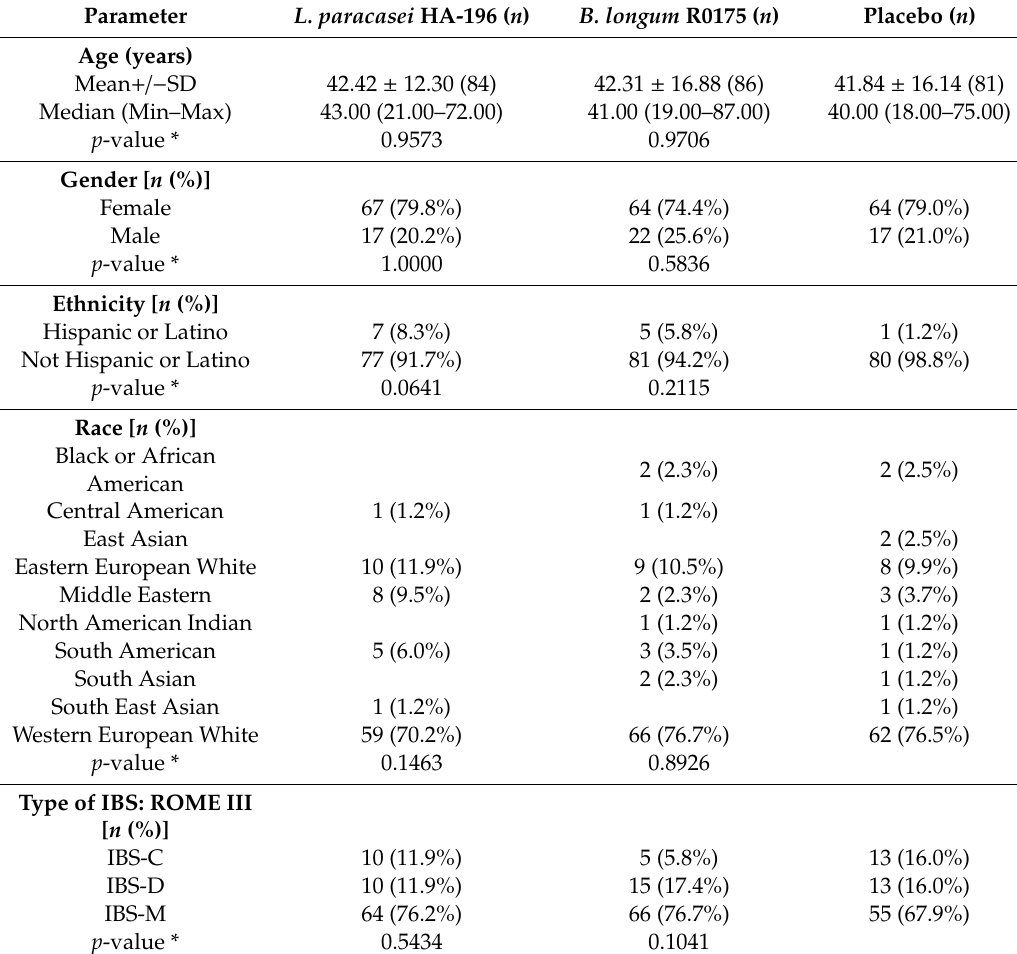
Table 1. Demographic characteristics for all participants in the per protocol (PP) population and their